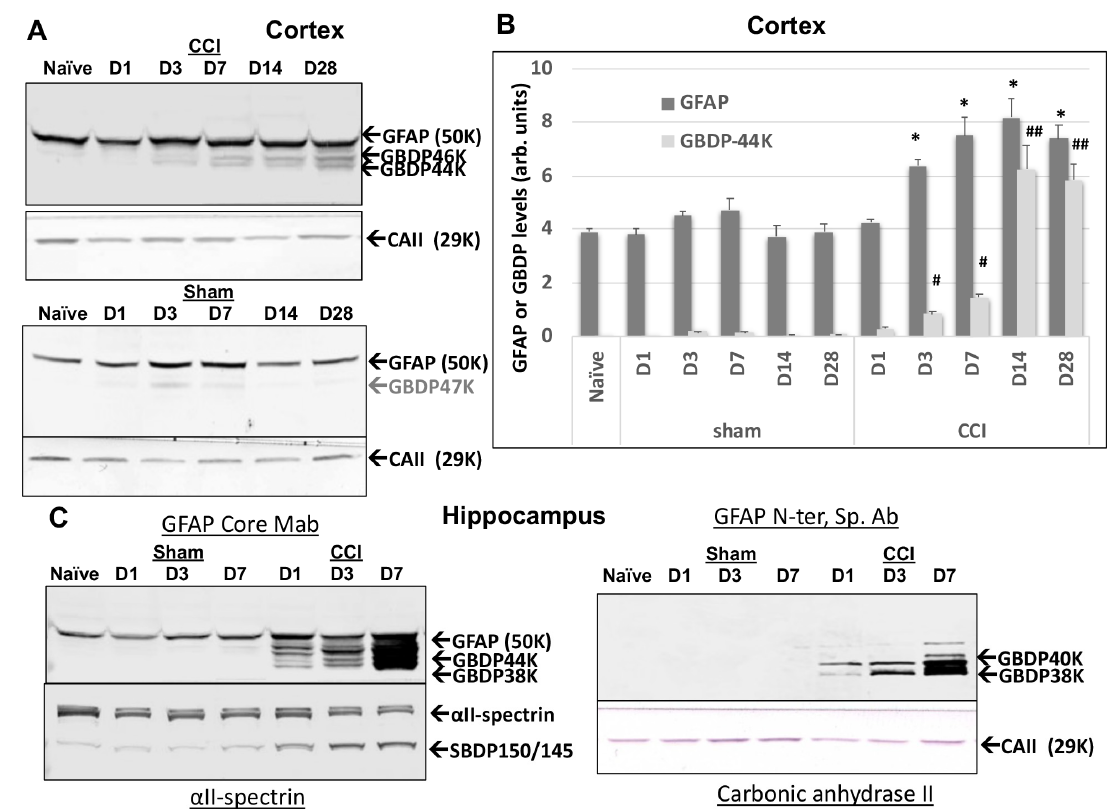
Figure 6. Ipsilateral cortex GFAP and GFAP-breakdown product (GBDP) profile by immunoblotting at different time points after controlled cortical impact (CCI) injury in mice. Time points are D1, 3, 7, 14, or 28 after injury. ( A ) Representative blots for GFAP and housekeeping gene loading control (Carbonic anhydrase II, 29 kDa). ( B ) Quantification of GFAP and GBDP-44K (equalized by CA-II band intensity). * p < 0.05, when compared with naïve GFAP, # p < 0.05; ##, p < 0.01, when compared with naïve GBDP-44K. ( C ) GBDP-specific MAb did not detect naïve or sham hippocampus but sensitively detected the formation of GBDP-40K and GBDP-38K at D3 and D7 post- CCI